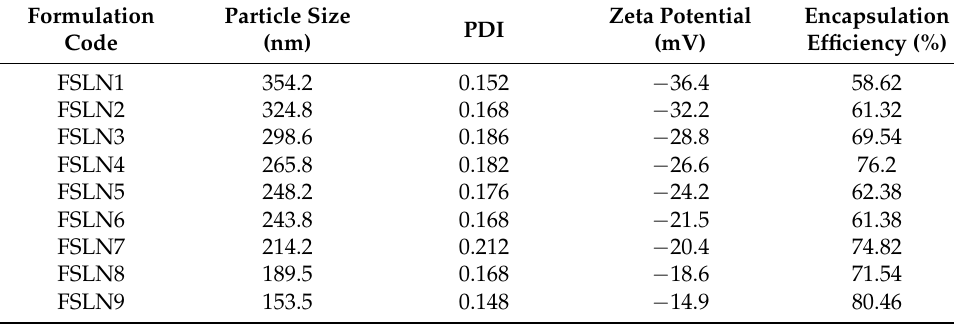
Table 2. Evaluation parameters of FLV-SLNP’s.